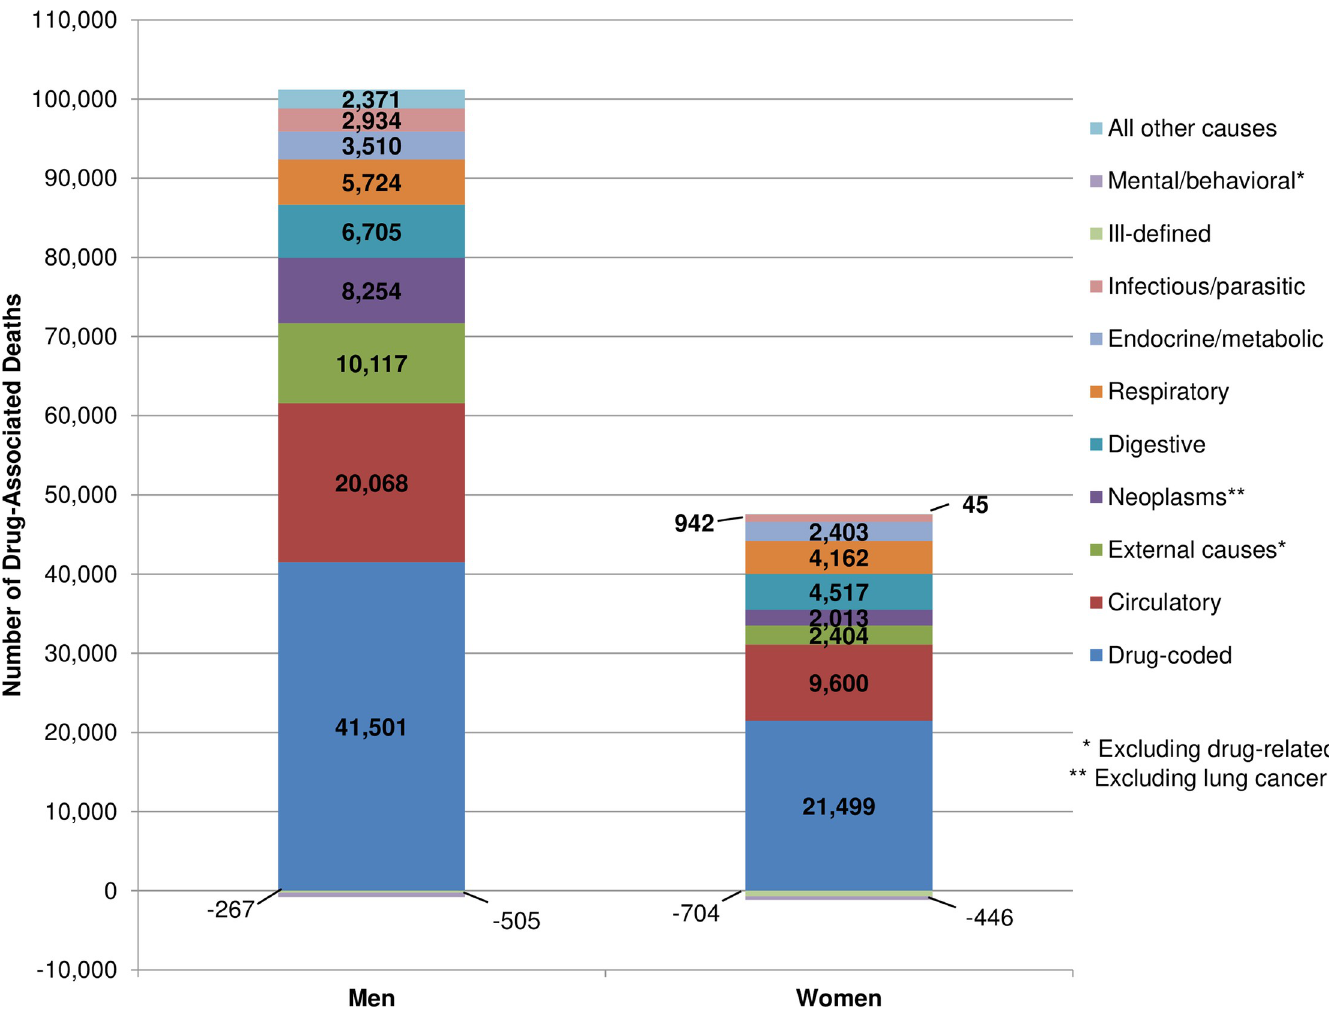
Fig 2. Estimated number of drug-associated deaths at ages 15–64 across groups of causes, by sex, US, 2016. Note: See S5 Appendix for ICD-10 codes that define each cause group. Negative values result when the model indicates an inverse association between drug-coded mortality and mortality from the specified cause group.